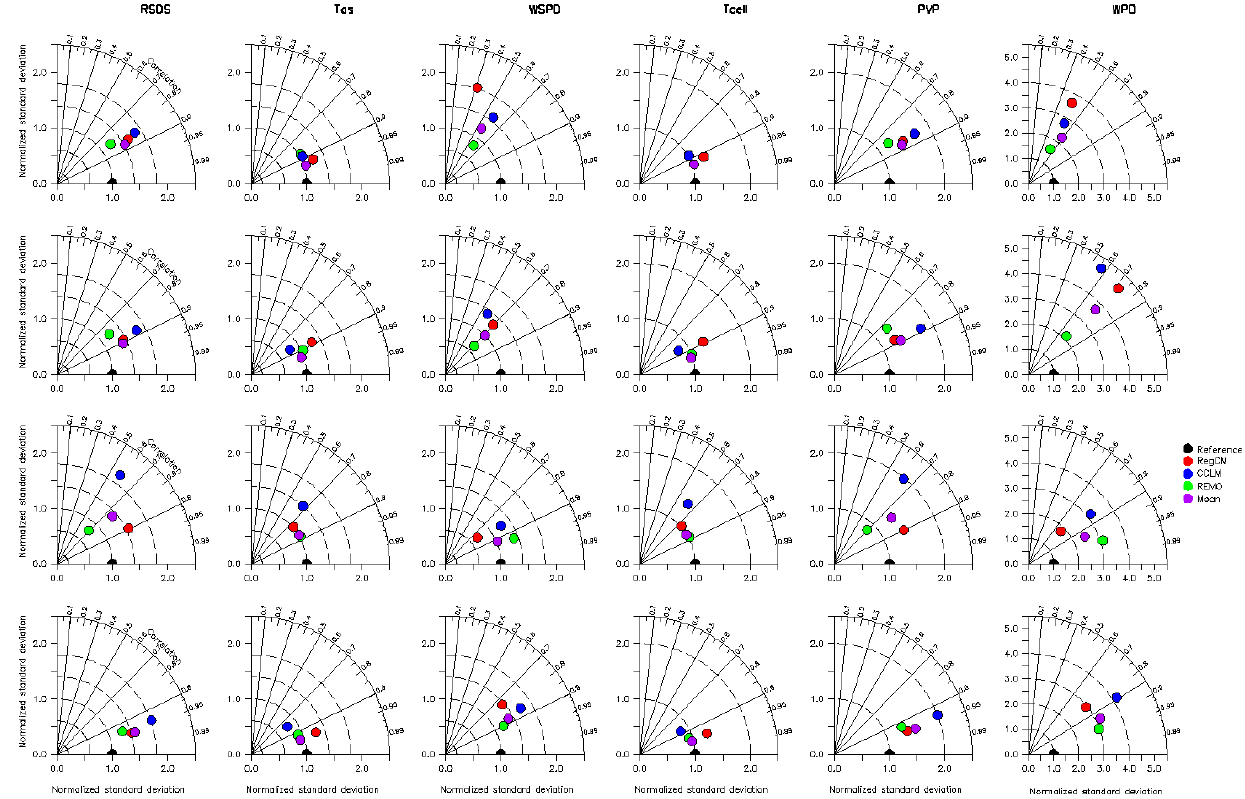
Figure 7. Taylor diagram of the observed and simulated solar irradiance (RSDS), ambient air temperature (Tas), surface wind speed (WSPD), cell temperature (T cell ), photovoltaic potential (PVP), and wind power density (WPD) in the reference period and over the three sub-regions of West